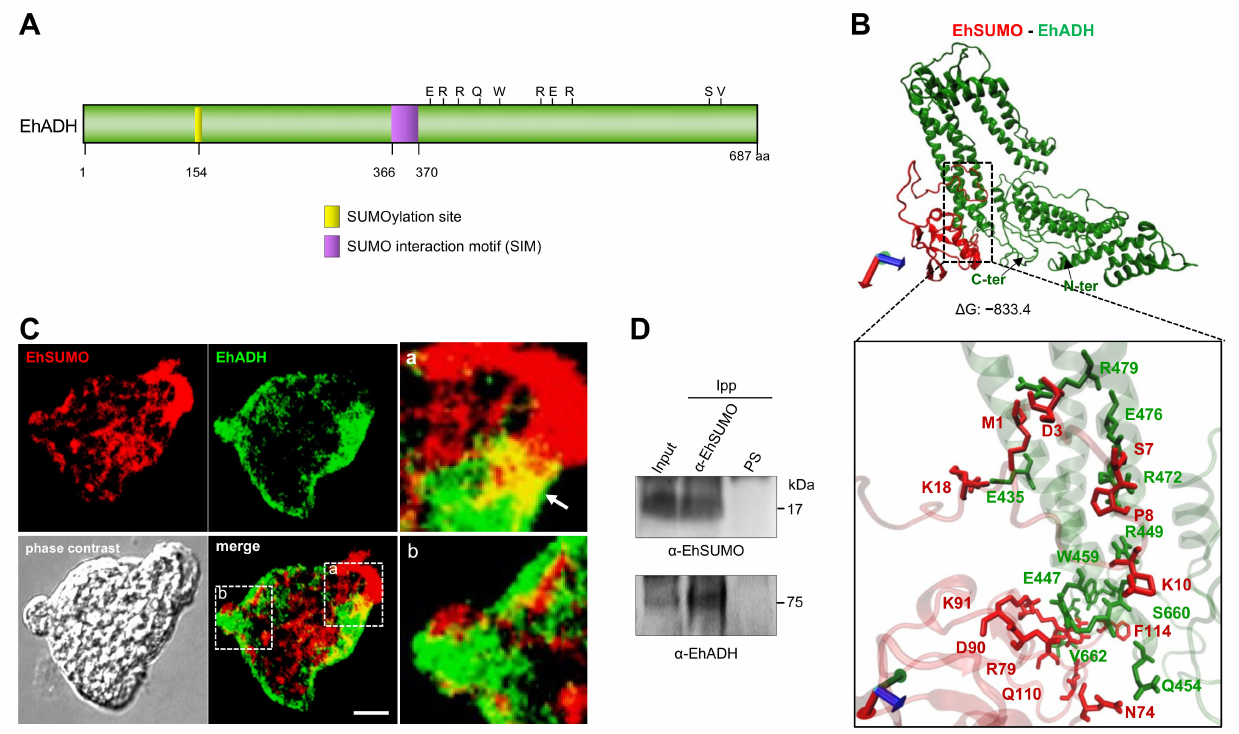
Figure 6. Association of EhSUMO and EhADH. ( A ) Schematic representation of EhADH protein with SUMOylation (yellow) sites and SIM sites (purple). ( B ) Molecular docking between predicted EhSUMO (red) and predicted EhADH (green). Square in the bottom: magnification of the interacting residues. Axes: x, red; y, green; z, blue. ( C ) Immunofluorescence assays of trophozoites under basal conditions using α -EhSUMO (red) and α -EhADH (green) antibodies. Regions in squares are magnified. Arrow: colocalization area. Scale bar = 10 µ m. ( D ) Western blot of Immunoprecipitates using trophozoites lysates and α -EhSUMO antibody or pre-immune serum (PS) and probed with α -EhSUMO or α -EhADH antibodies. Numbers at right: molecular weight of immunodetected